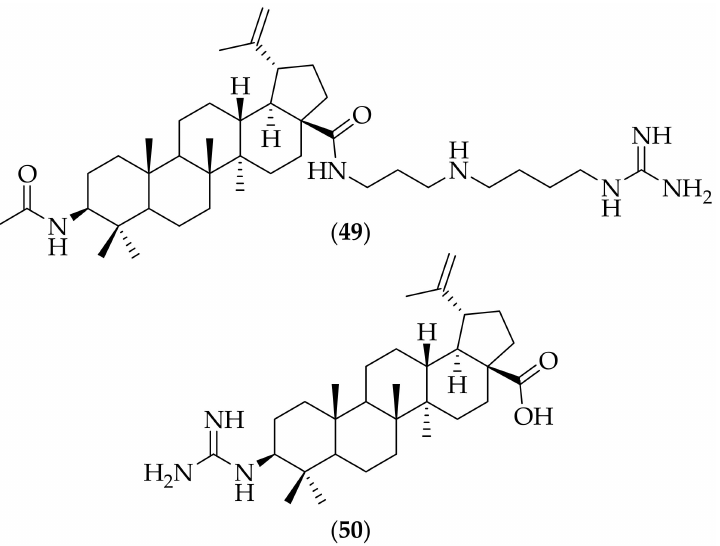
Figure 32. Guanidine-containing betulinic acid derived antifungal analogs ( 49 ) and ( 50 ). Perez and coworkers described their synthesis and biological evaluation of two guanidine-containing surfactants in 2021, [72]. The two surfactants synthesized were ( 51 ), and ( 52 ), Figure 33, and these were evaluated using multiple methods. The two compounds were assayed for their antifungal activity against nine Candida strains, and both compounds displayed MIC values of 8.12 µ g/mL for all nine strains, appreciably less active than the positive controls fluconazole and amphotericin B. It is very surprising that the MIC values for all nine strains were exactly the same. The compounds were